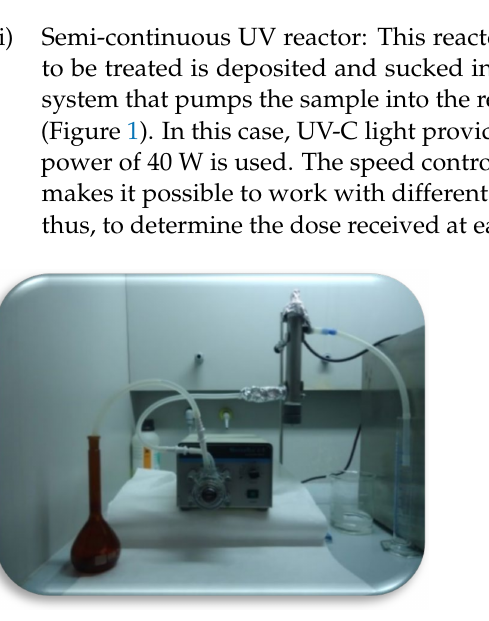
Figure 1. Semi-continuous reactor used for the degradation of terbuthylazine in ultrapure water, groundwater and water from the Gaditana area.